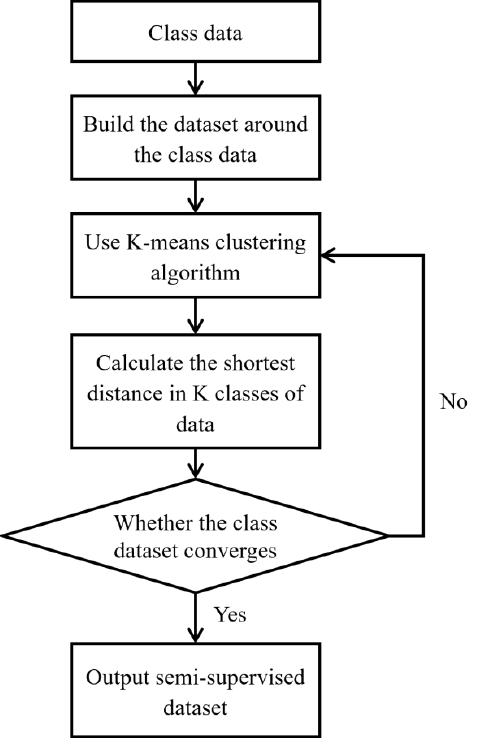
Figure 2. Flowchart of the date expansion based on semi-supervised learning.